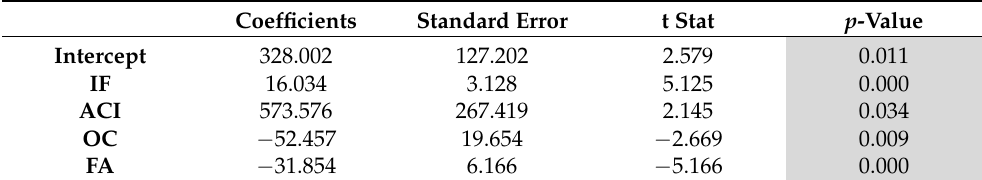
Table 5. The significance of IF, ACI, OC, and FA on the DP